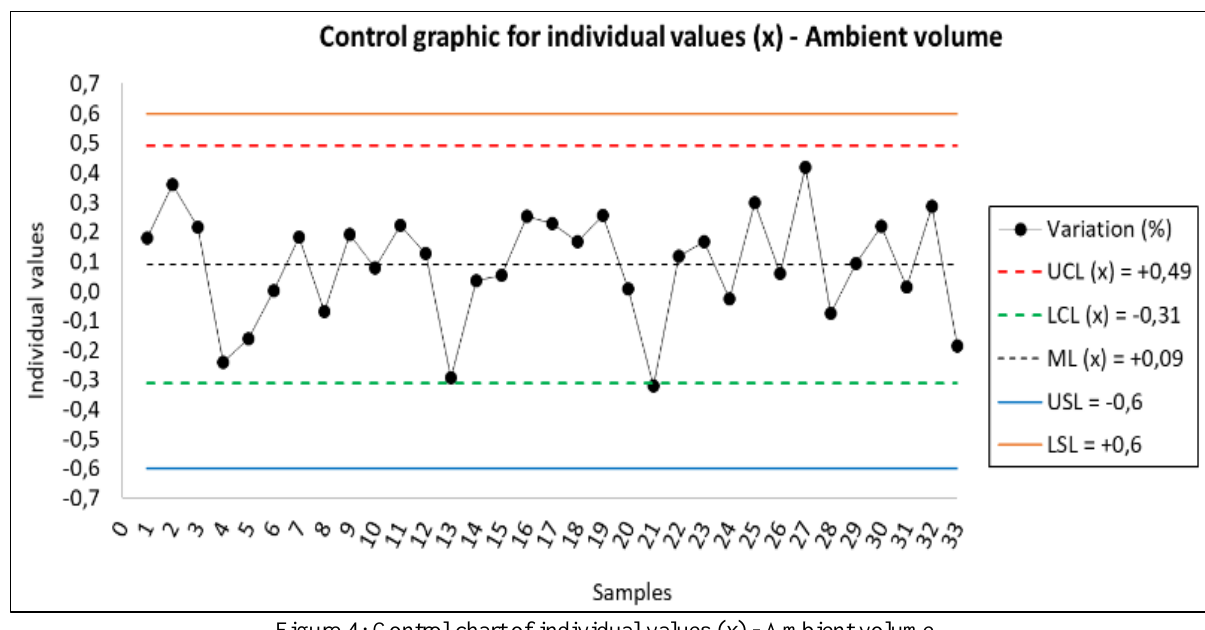
Figure 3: Graph of values and specification limits for Ambient Volume.